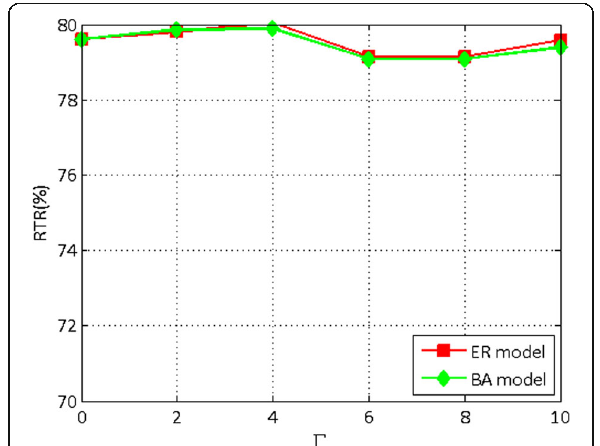
d ; N ; Γ ¼ 6) UE ¼ 4 UE ¼ 60